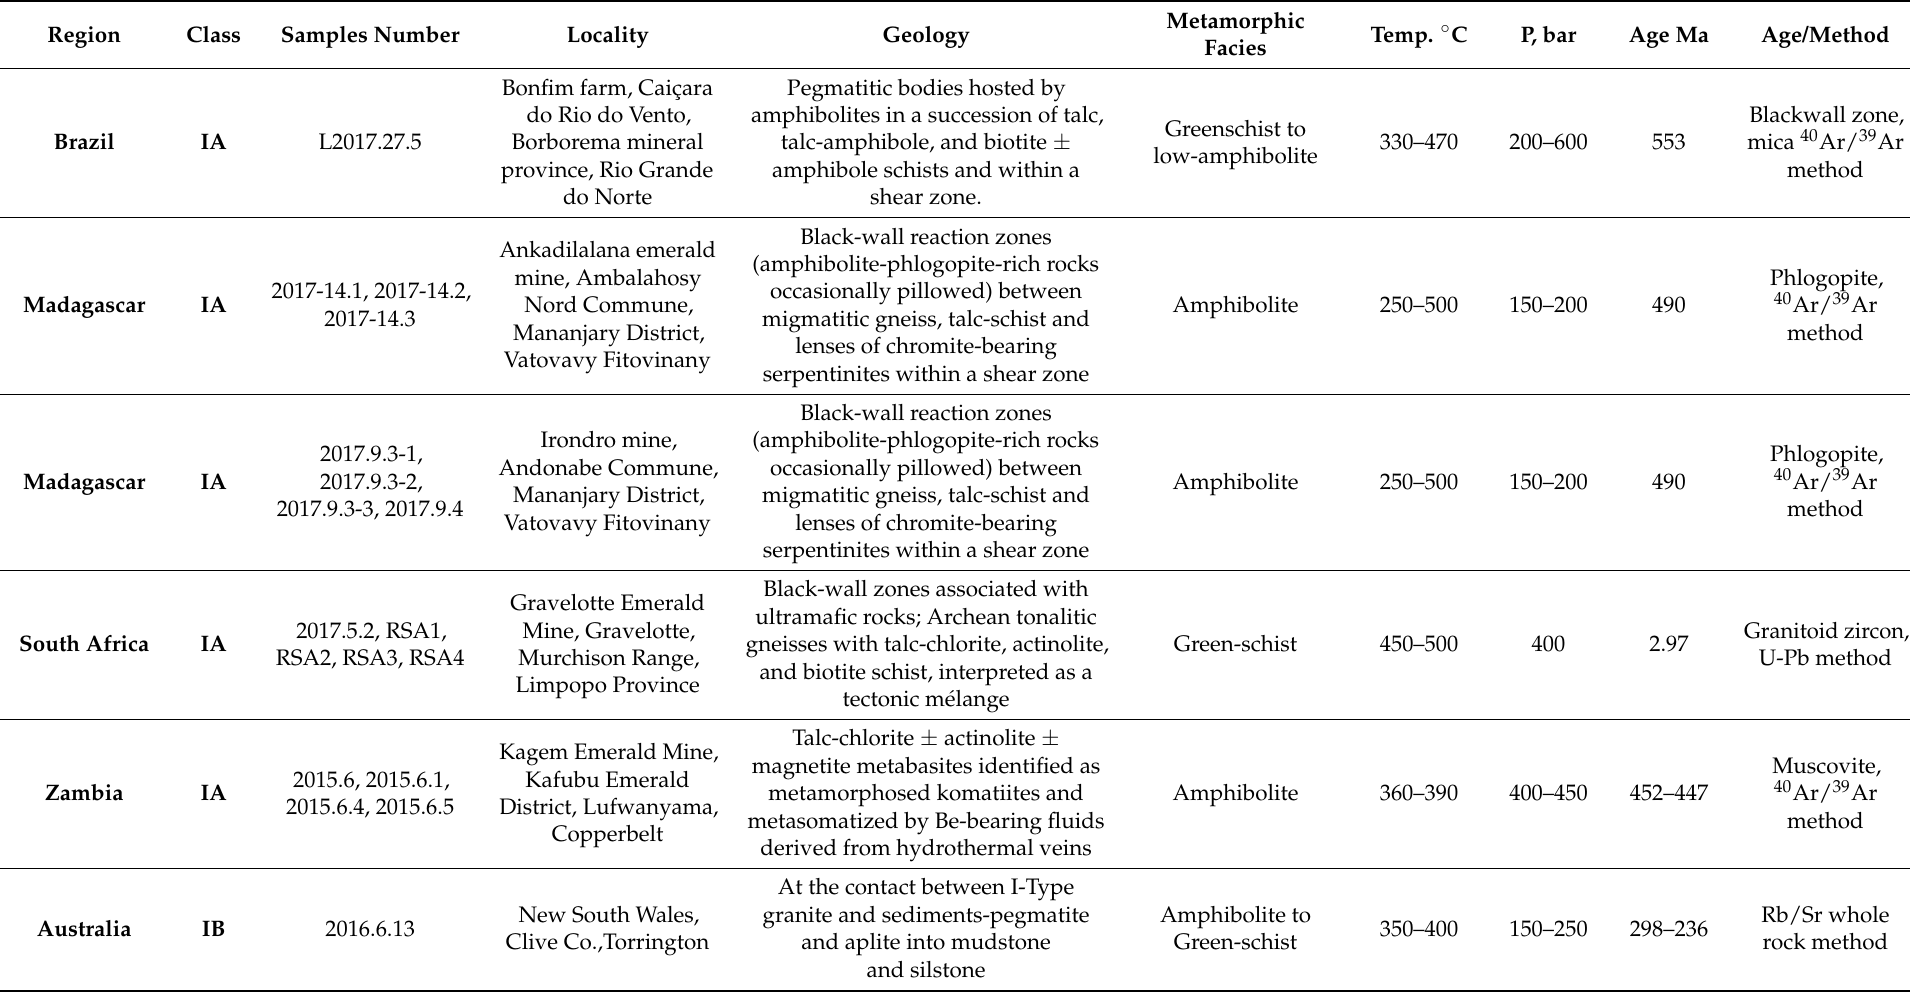
Table 1. Geological information for emeralds examined in this